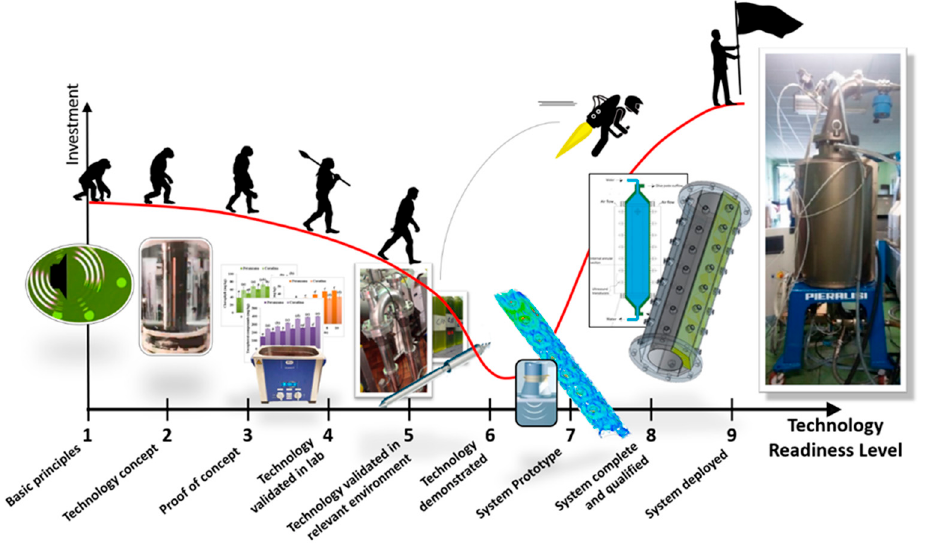
Figure 1. The stages of the TRL—technology readiness level—in the development of the Sono-Heat- Exchanger.